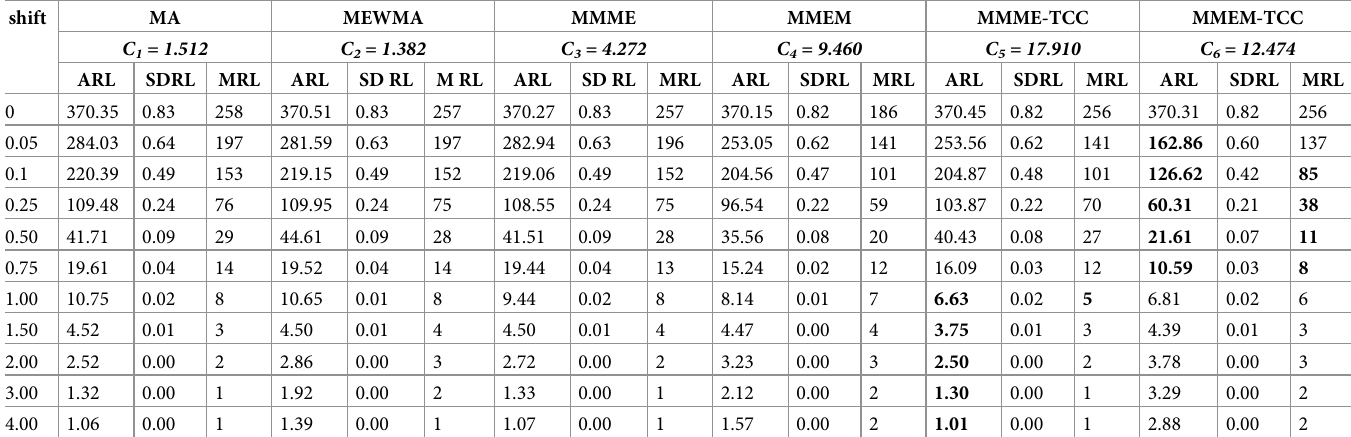
Table 4. The run length attributes of the proposed MMEM-TCC chart and existing control charts for gamma